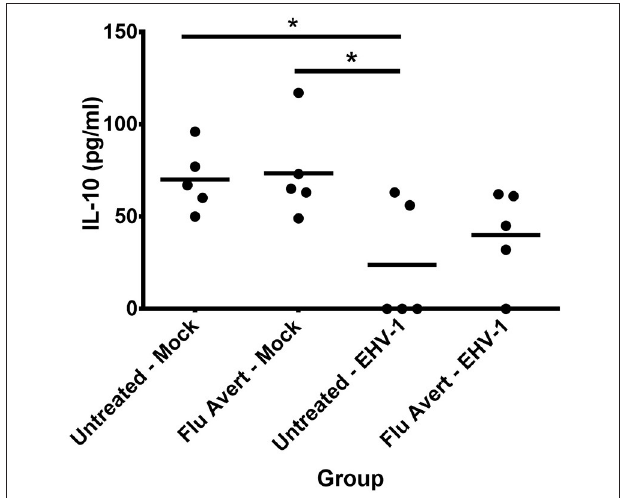
FIGURE 7 | IL-10 protein expression in EREC supernatants collected from five horses. ERECs were treated with Flu Avert (or left untreated) on day 7 prior to EHV-1 inoculation, and supernatants of cultures were collected 72h post-EHV-1 infection. The mean concentration (pg/ml) is represented by a bar (* p <